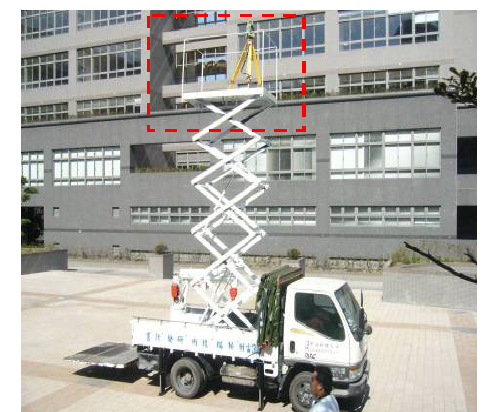
Figure 5. lift-able car and movable